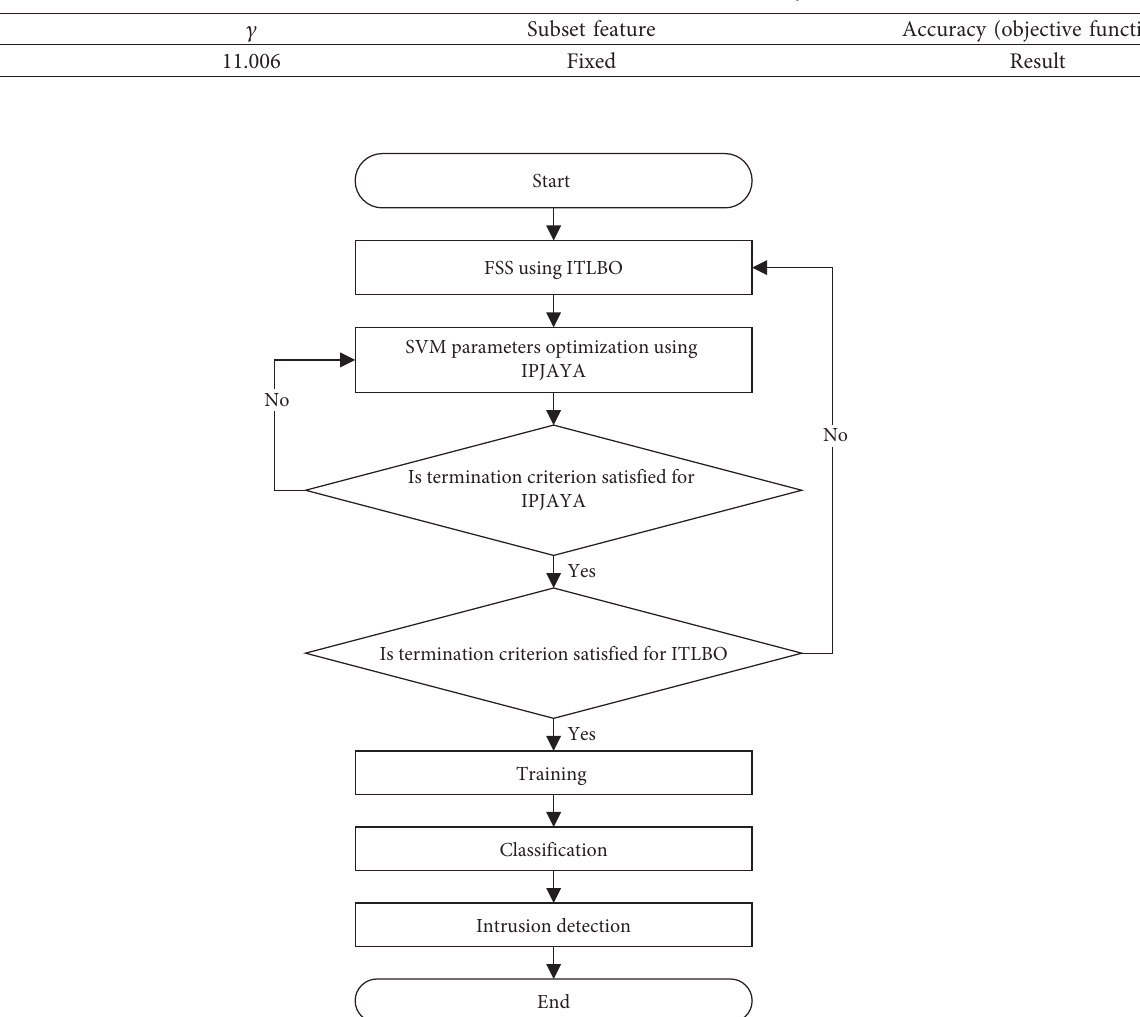
Table 7: Evaluation of features based on new C and c .